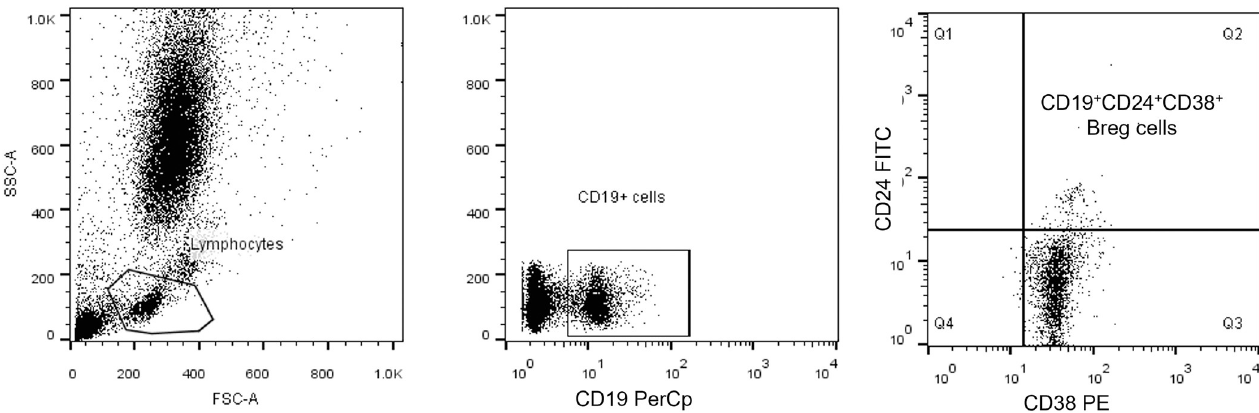
Fig 3. Flow cytometric detection of regulatory B cells. A : Scatter histogram was used to define the lymphocytes population. B : The CD19 + cells were assessed within the lymphocyte population and then gated for further assessment of CD24 and CD38. C : The expression of CD24 and CD38 was assessed in CD19 + lymphocytes to define CD19 + CD24 +high CD38 +high cells (regulatory B cells).